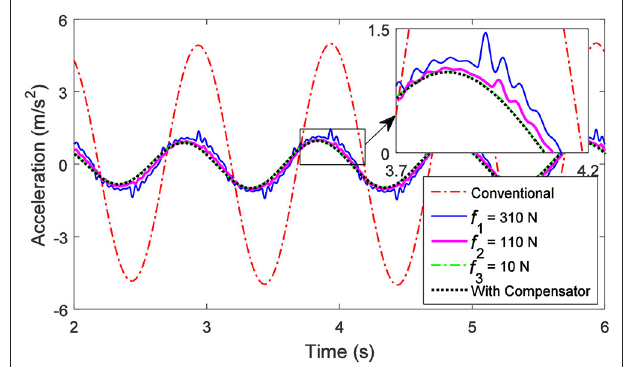
FIGURE 14 | Acceleration response of the single-degree-of-freedom vibration system under a sinusoidal displacement excitation with an amplitude of 50mm and a frequency of